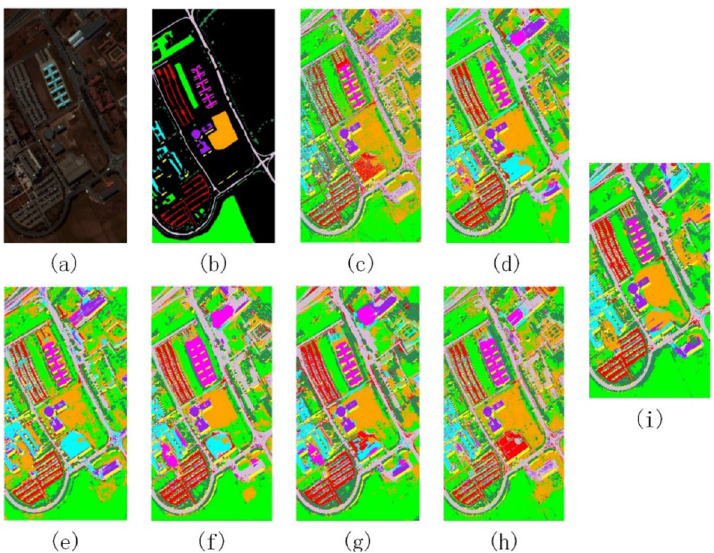
Figure 9. Pavia University data classification results. ( a ) False-color map; ( b ) Ground-truth map; ( c ) PCA; ( d ) EMP; ( e ) SAE; ( f ) 3D-CNN; ( g ) Gabor-Based; ( h ) RPNet; ( i ) Ours.